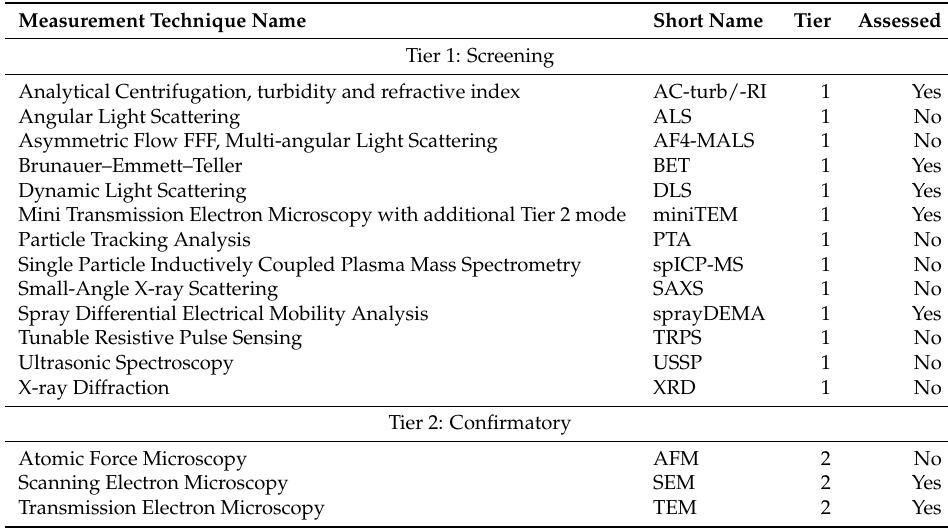
Table 2. Measurement techniques considered in the NanoDefine project, tiered into screening (Tier 1) and confirmatory (Tier 2) techniques.